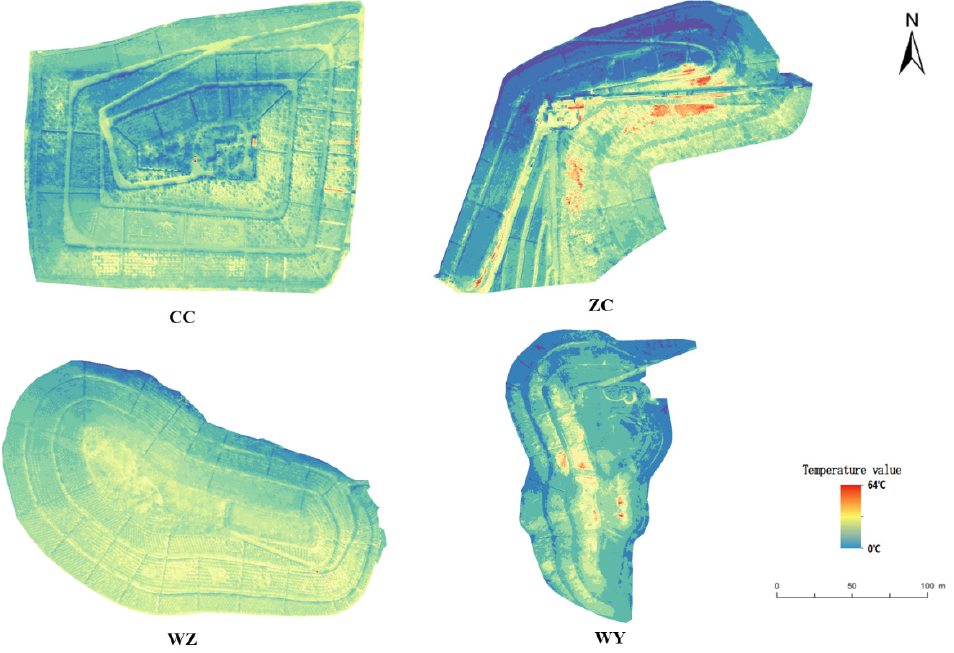
Figure 3. Temperature distribution map of four coal gangue piles.